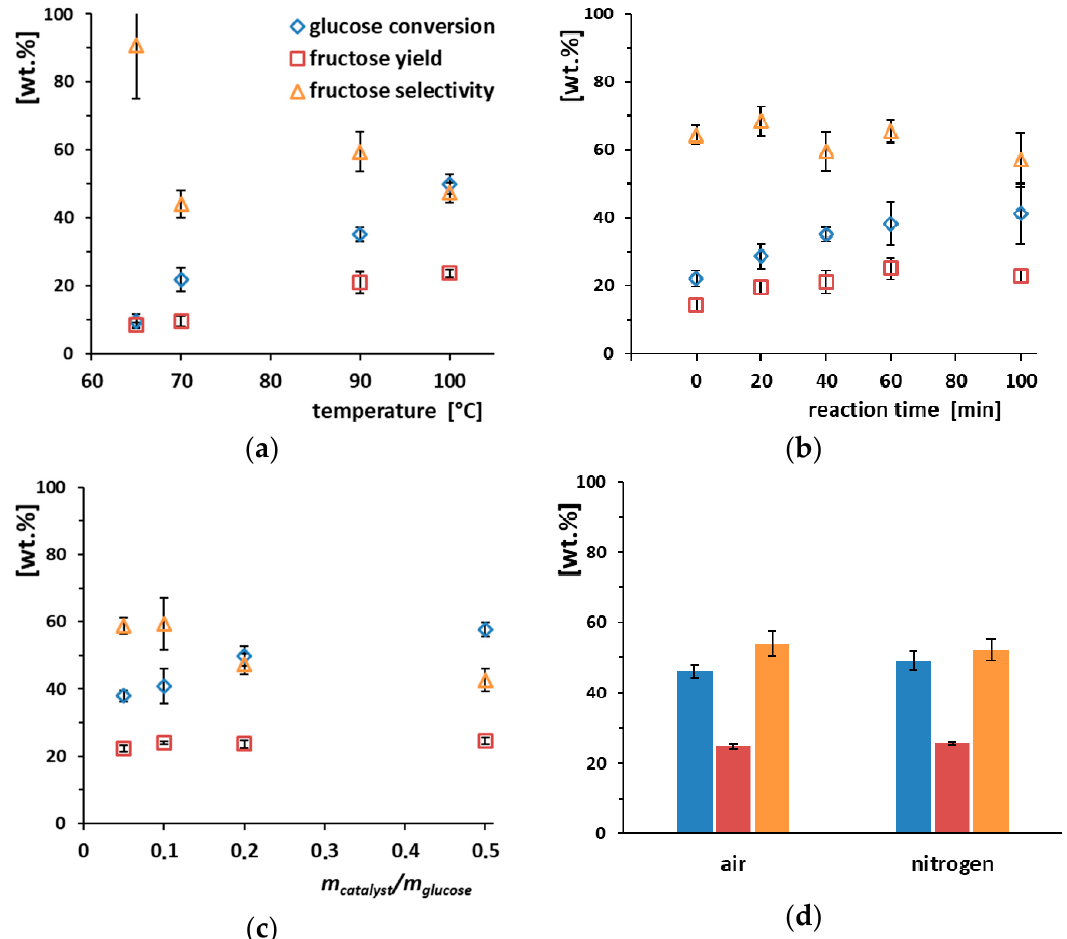
Figure 3. Glucose conversions and fructose yields using calcinated hydrotalcite with variation of ( a ) the temperature; ( b ) reaction time, for t = 0 min, sample was heated up to the reaction temperature and then directly cooled down; and ( c ) mass ratio of catalyst to glucose at T = 100 °C; and ( d ) gas atmosphere; always constant parameters: c glucose = 5 g/L, pH ≈ 7; parameters (unless otherwise stated): air atmosphere, T = 90 °C, t = 40 min, m catalyst /m glucose = 0.2.